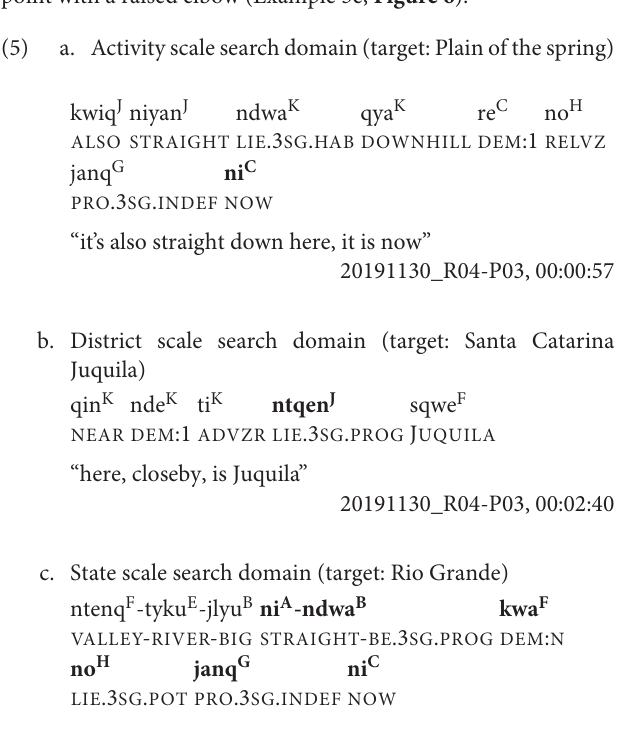
Catarina Juquila, a district scale target, she indicates the town using the proximal demonstrative nde C and a point with a raised elbow (Example 5b, Figure 5 ). When indicating Rio Grande, a state scale target, she uses the neutral demonstrative kwa F and a point with a raised elbow (Example 5c, Figure 6 ).